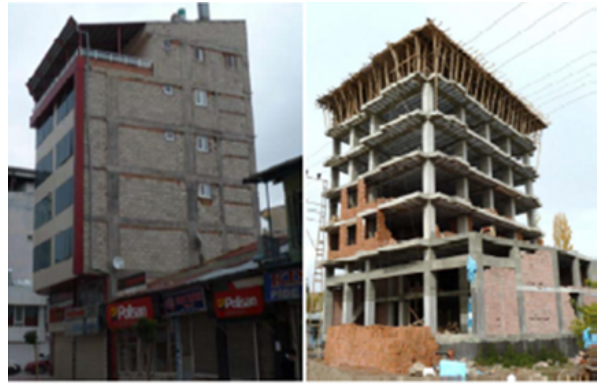
Figure 20. Buildings that do not have adequate shear